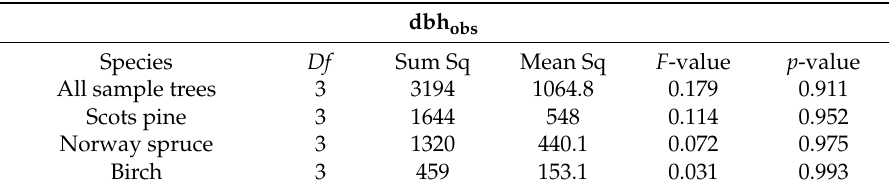
Table 2. The results of ANOVA analysis for dbh obs measurements for all sample trees as well as for different tree species with degrees of freedom (Df), sum of squares (Sum Sq), mean squared error (Mean Sq), F -value and p -value. dbh obs Species Df Sum Sq Mean Sq F -value p -value All sample trees 3 3194 1064.8 Scots pine 0.952 Norway spruce 1320 440.1